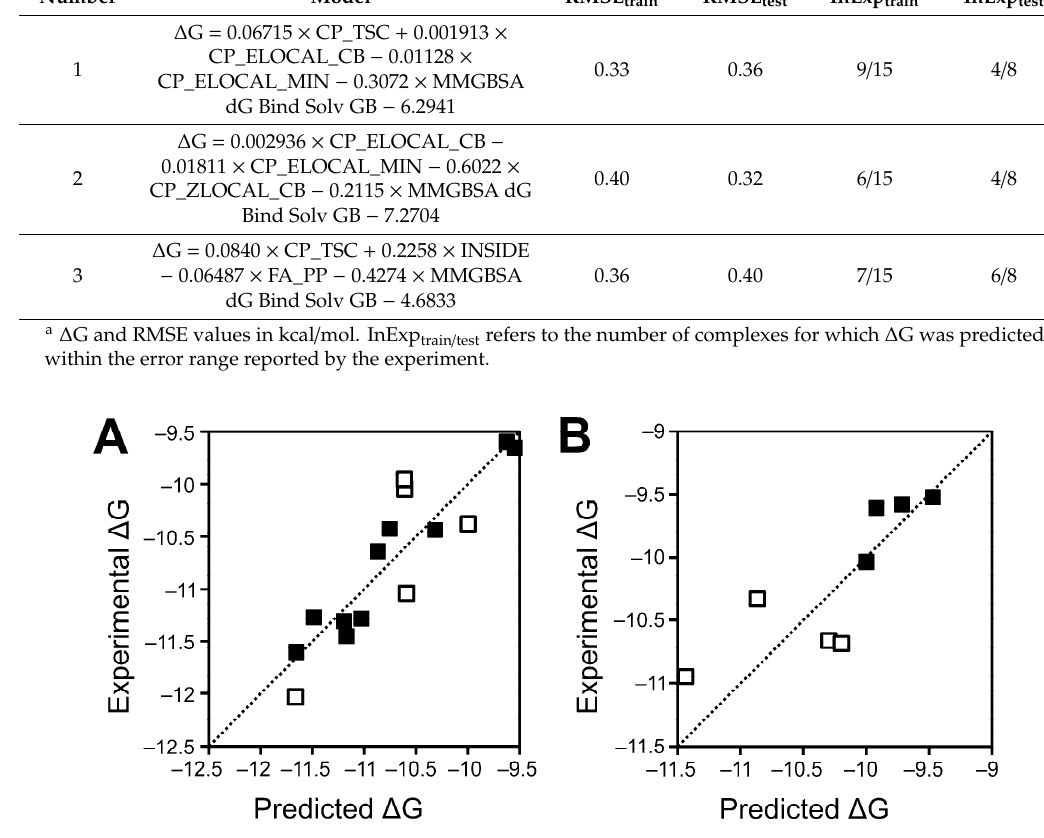
Figure 2. Comparison of experimental and predicted binding energies by Model 1 for training ( A ) and test ( B ) sets.